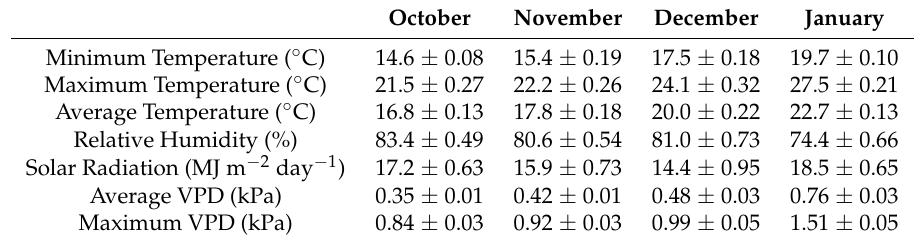
Table 1. Environmental conditions during the experimental period 2017–2018 (E1). Average daily values ± standard error. VPD—Vapor pressure deficit.